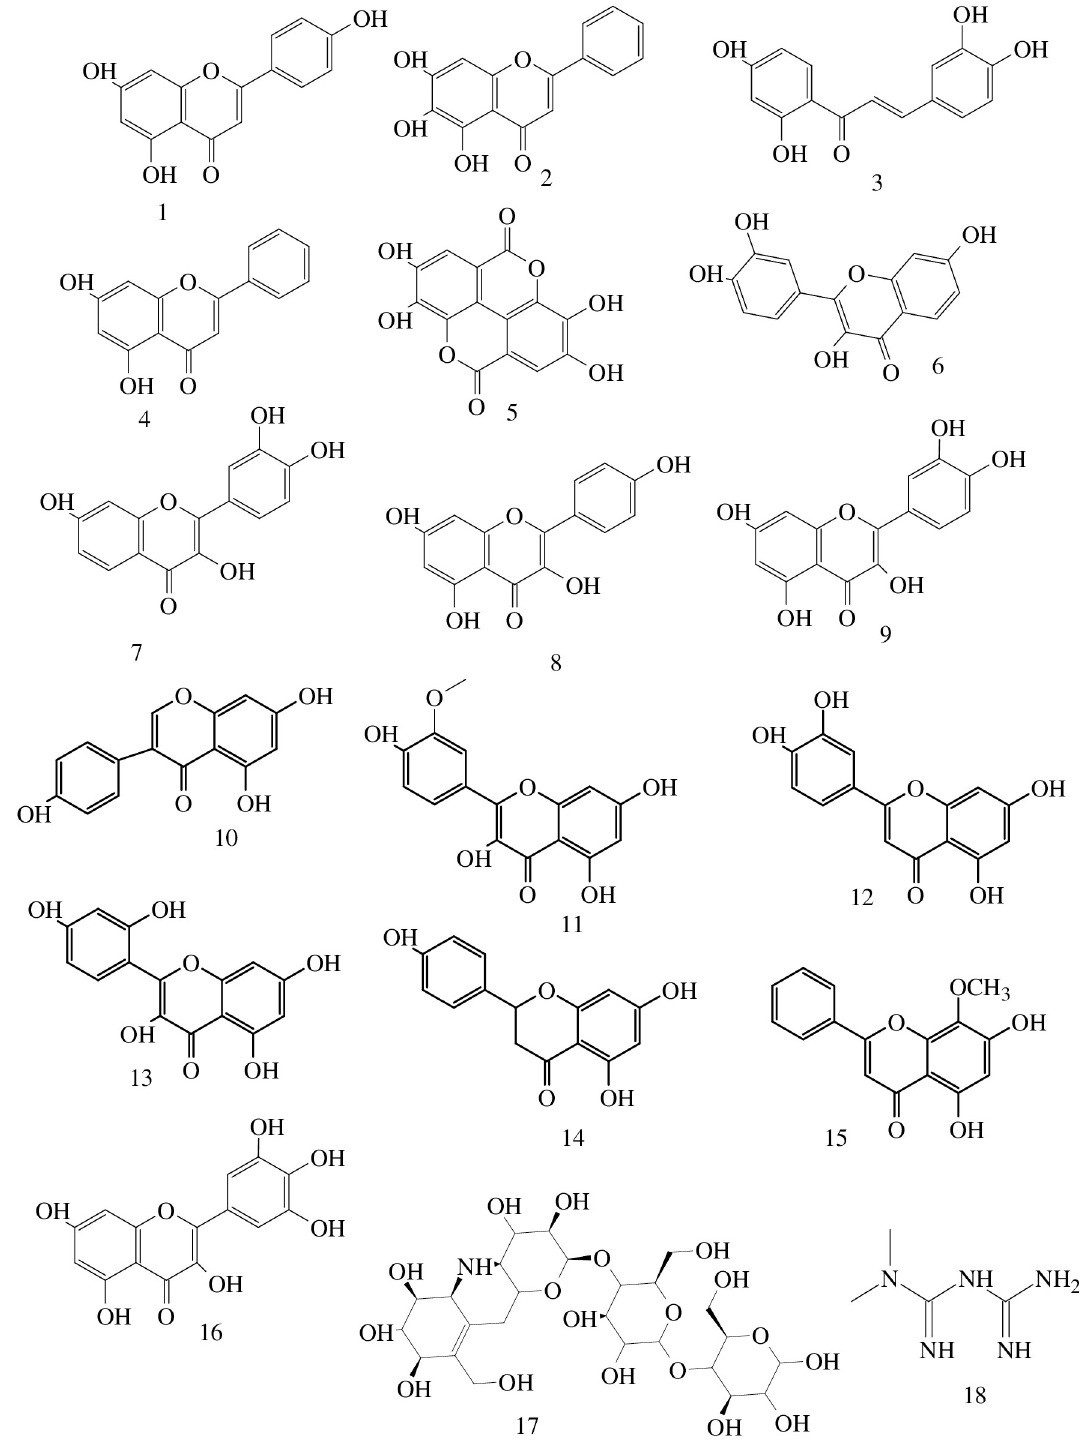
Fig 2. The structures of the flavonoid derivatives considered in this study. The numbers ( 1 to 18 ) stand for 1 = Apigenin, 2 = Baicalein, 3 = Butein, 4 = Chrysin, 5 = Ellagic acid, 6 = Eriodyctiol, 7 = Fisetin, 8 = Kaempferol, 9 = Quercetin, 10 = Genistein, 11 = Isorhamnetin, 12 = Luteolin, 13 = Morin, 14 = Naringenin, 15 = Wogonin, 16 = Myricetin, 17 = acarbose and 18 = metformin.